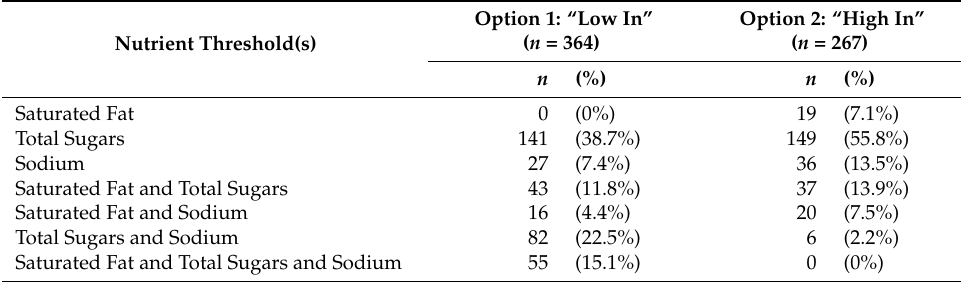
Table 4. Proportion of food products that are not permitted to be marketed to children according to specific nutrient threshold(s) exceeded in the Health Canada model.